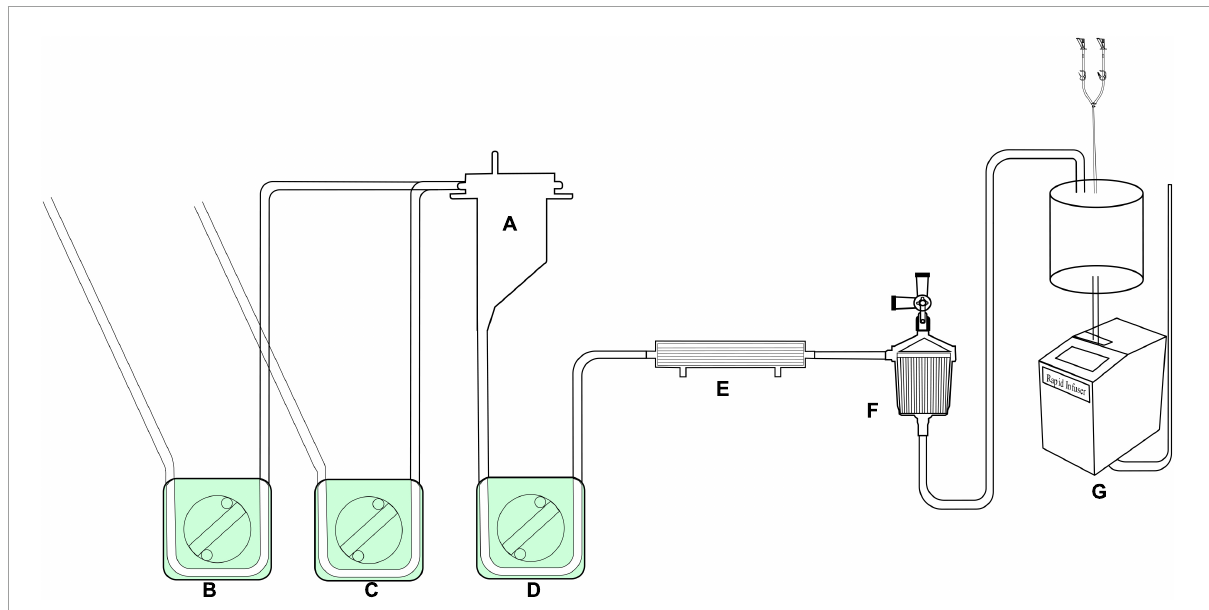
FIGURE5 The assembled reserved LHB circuit for the sucker and rapid-infusion perfusion. A , Hard-shell reservoir for shed filed blood collection by the pump suckers. B,C , roller pumps for suckers; D , roller pump for shifting blood to the rapid-infusion system; E , ultrafilter, F , arterial filter, G , rapid-infusion system.